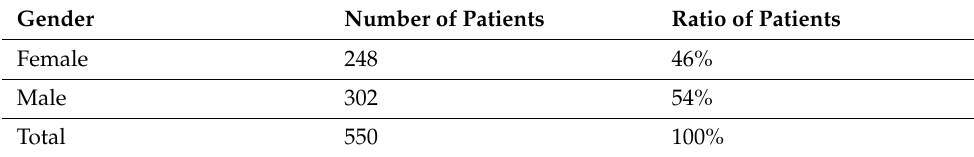
Table 2. Age and gender distribution of patients with third molar numbers.